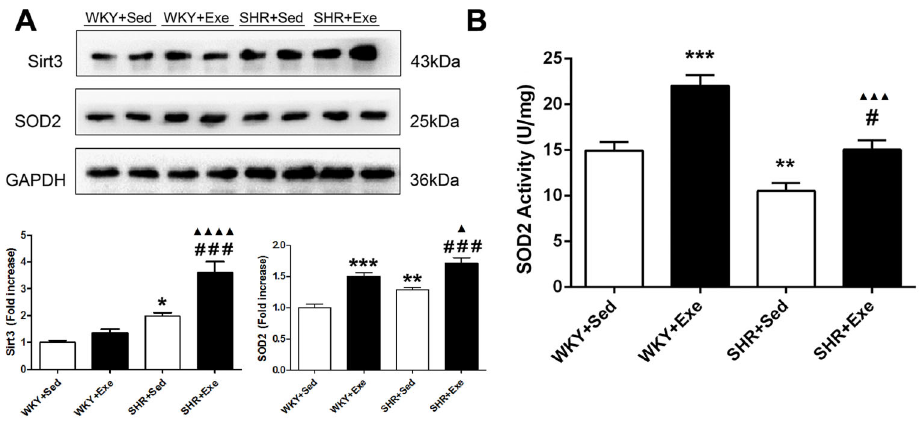
Figure 5. A , Representative blots of SIRT3 in cardiac tissues in sedentary or exercised Wistar-Kyoto rats (WKY + Sed, WKY + Exe) and in sedentary or exercised spontaneously hypertensive rats (SHR + Sed, SHR + Exe) after 16 weeks of moderate-intensity exercise are presented in the upper panel. Quanti fi cation of immunoreactive bands is presented in the lower panels. B , Superoxide dismutase (SOD2) activity in cardiac tissues of the same groups. Data are reported as means ± SE (n=4 for A and n=5 for B ). *P o 0.05, **P o 0.01, ***P o 0.001 vs WKY + Sed group; m P o 0.05, mmm P o 0.001, mmmm P o 0.0001 vs WKY + Exe group; # P o 0.05, ### P o 0.001 vs SHR + Sed group